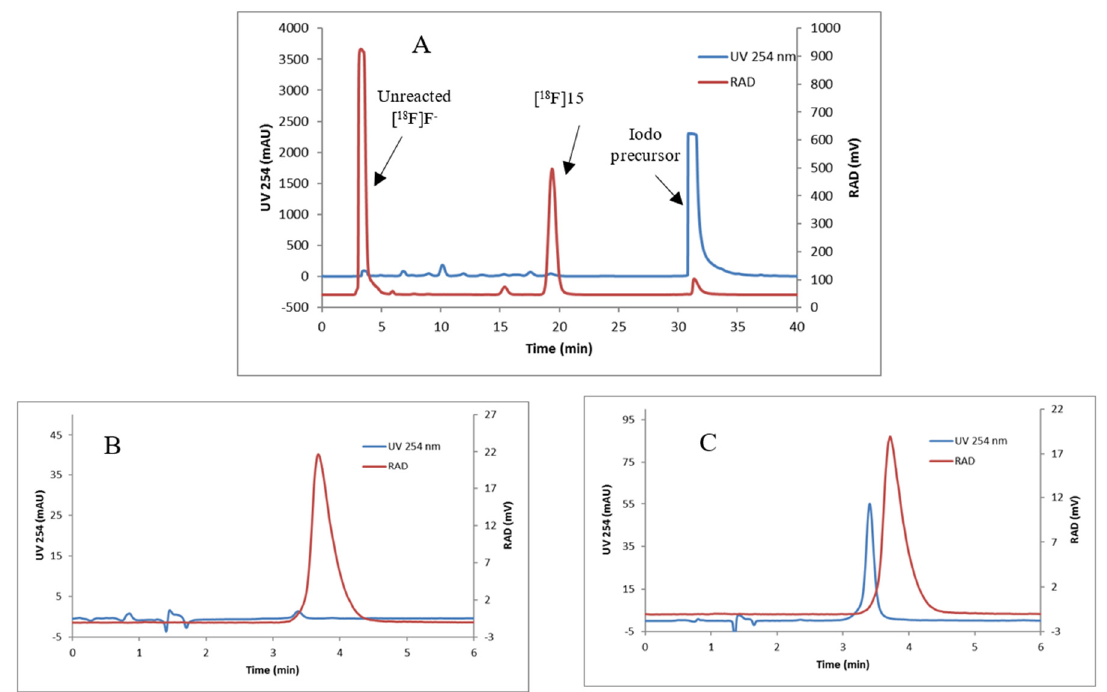
Figure 4. ( A ) Semi-preparative HPLC chromatogram of [ 18 F] 15 purification; ( B ) analytical HPLC chromatograms of purified [ 18 F] 15 ; ( C ) co-injected with the nonradioactive standard. Red line, in-line radiodetector; blue line, UV detector at 254